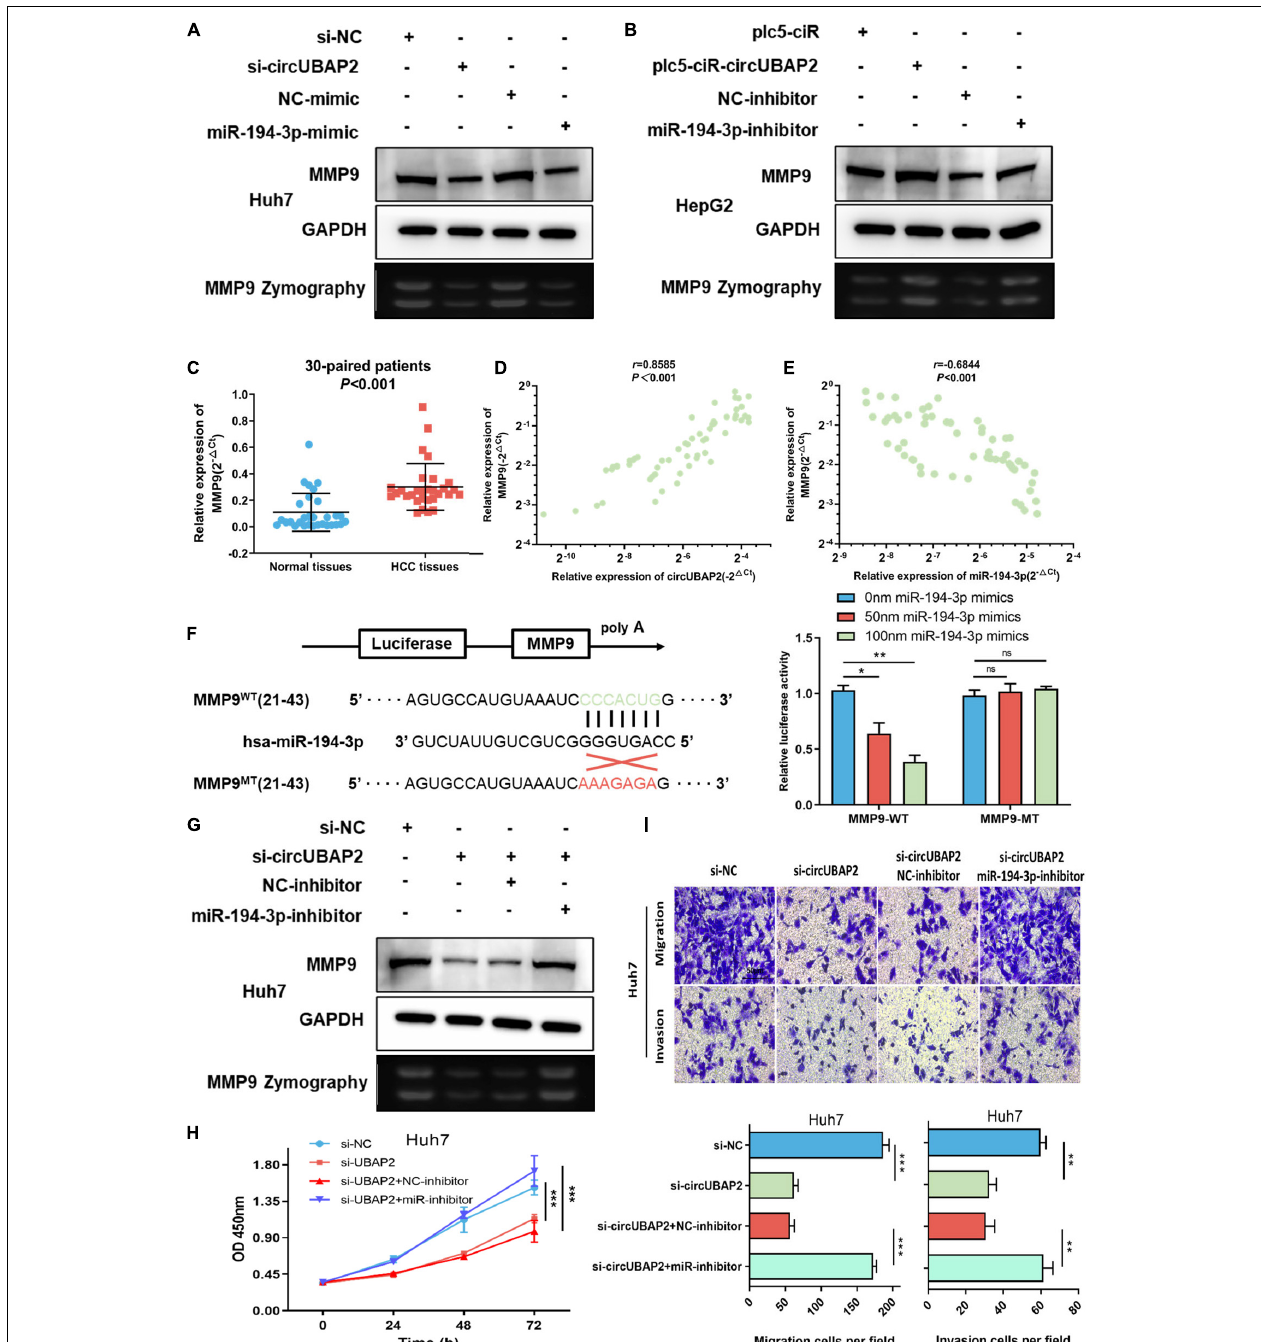
FIGURE 5 | CircUBAP2 promotes the progression of HCC through the miR-194-3p-MMP9 pathway. (A,B) Western-blot (WB) and zymography experiments examined the expression levels of MMP9 in HCC cells after silencing or overexpressing circUBAP2 or miR-194-3p. (C) The expression level of MMP9 was further assessed in 30 HCC tissues and paired normal tissues. (D) MMP9 level was positively correlated with circUBAP2 levels, which was validated by RT-qPCR in 30 HCC tissues. The correlation was evaluated by Pearson correlation analysis. (E) MMP9 level was negatively correlated with miR-194-3p levels, which was validated by RT-qPCR in 30 HCC tissues. The correlation was evaluated by Pearson correlation analysis. (F) WT and MT sequences of the putative binding sites between miR-194-3p and MMP9 mRNA. Luciferase activity in HA22T cells co-transfected with luciferase reporters containing MMP9 sequences with wild-type or mutated miR-194-3p binding sites and mimics of miR-194-3p or controls. (G) WB and zymography experiments analyzed the expression of MMP9 in HCC cells after treatment with si-circUBAP2 alone or combined with si-circUBAP2 and miR-194-3p inhibitors. (H) CCK-8 assays analyzed the proliferation of HCC cells after treatment with si-circUBAP2 alone or combined with si-circUBAP2 and miR-194-3p inhibitors. (I) Transwell assays analyzed the migration of HCC cells after treatment with si-circUBAP2 alone or combined with si-circUBAP2 and miR-194-3p inhibitors. ns means P > 0.05, * P > 0.05, ** P > 0.01 and *** P >